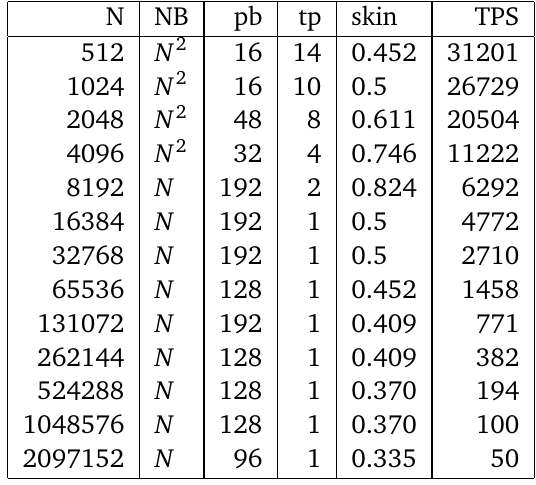
Table 2: Performance parameters chosen by the autotuner and the resulting TPS (Timesteps Per Second) on a Gtx780Ti card (5.0 TFlops sp, 336GB /